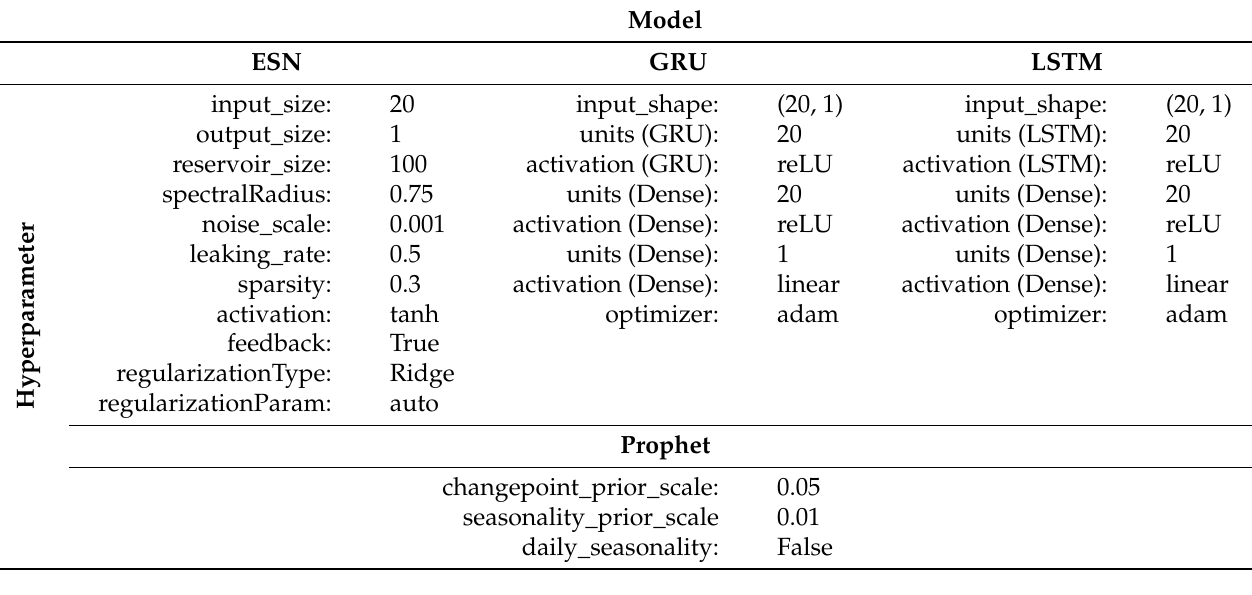
Table 1. Models setting used for strategy A.